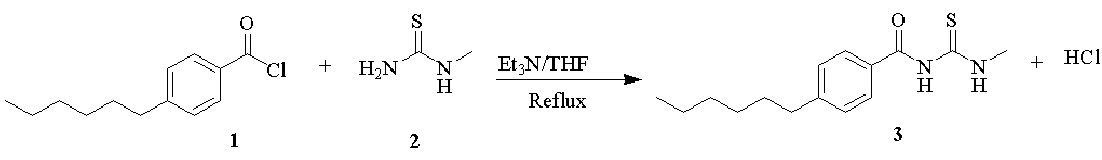
Figure 1. The scheme of reaction between 4-hexyl benzoyl chloride with N -methylthiourea.